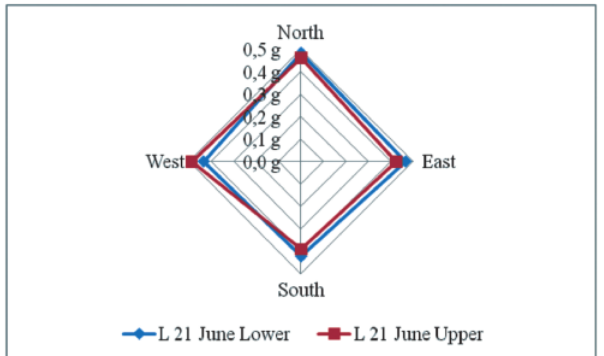
Fig. 9: Stone mass in the function of orientation and height in the case of Linda